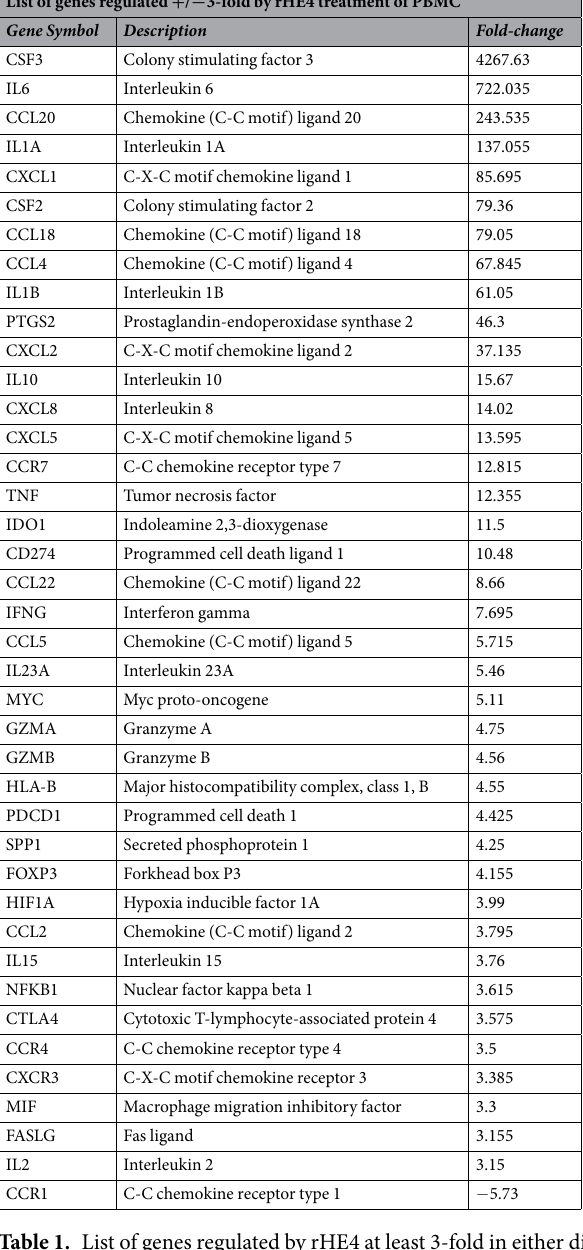
Table 1. List of genes regulated by rHE4 at least 3-fold in either